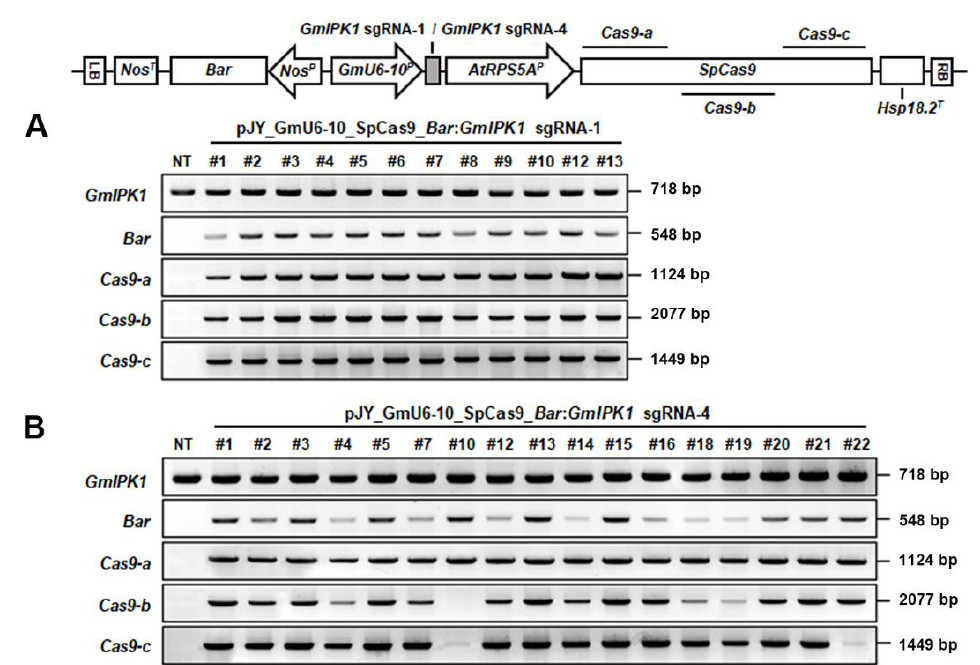
Figure 4. Confirmation of introduced genes from Gmipk1 gene-edited soybean transgenic plants (T 0 ) by PCR analysis. Genomic DNA was extracted from GmIPK1 sgRNA-1 ( A ) and GmIPK1 sgRNA-4 ( B ) T 0 transgenic leaves to confirm the integration of GmIPK1 and Bar genes. The inserted SpCas9 , divided into three parts ( SpCas9 -a, SpCas9 -b, and SpCas9 -c), was analyzed by PCR: NT, nontransgenic plant; ( A ) GmIPK1 sgRNA-1 transgenic lines (#1–#10, #12, #13); ( B ) GmIPK1 sgRNA-4 transgenic lines (#1–#5, #7, #12–#16, #18-#22).